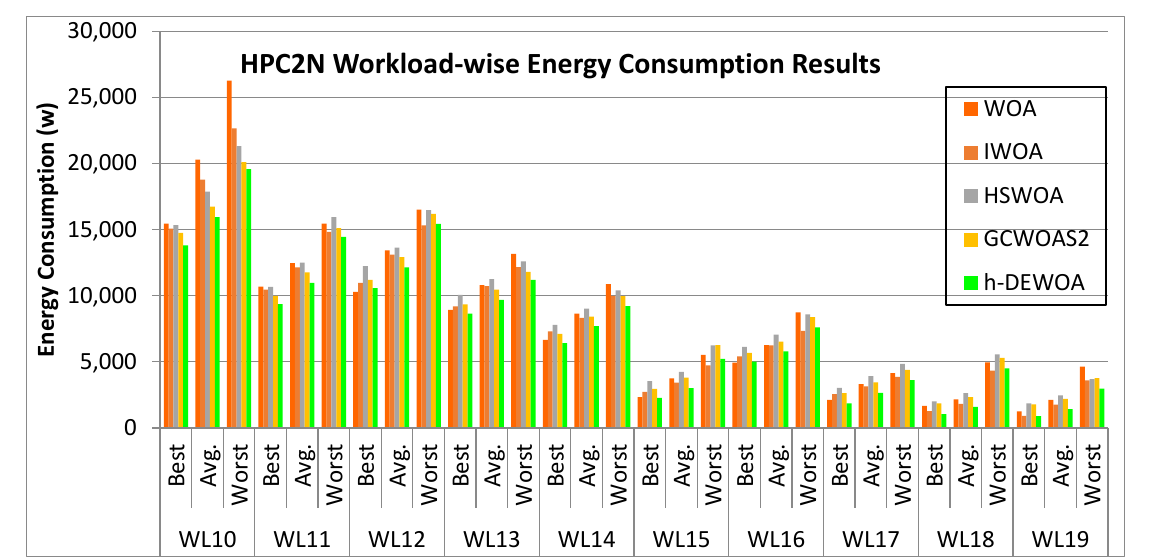
Figure 10. Statistical results of the energy consumption objective for WL10 – WL19 workloads .